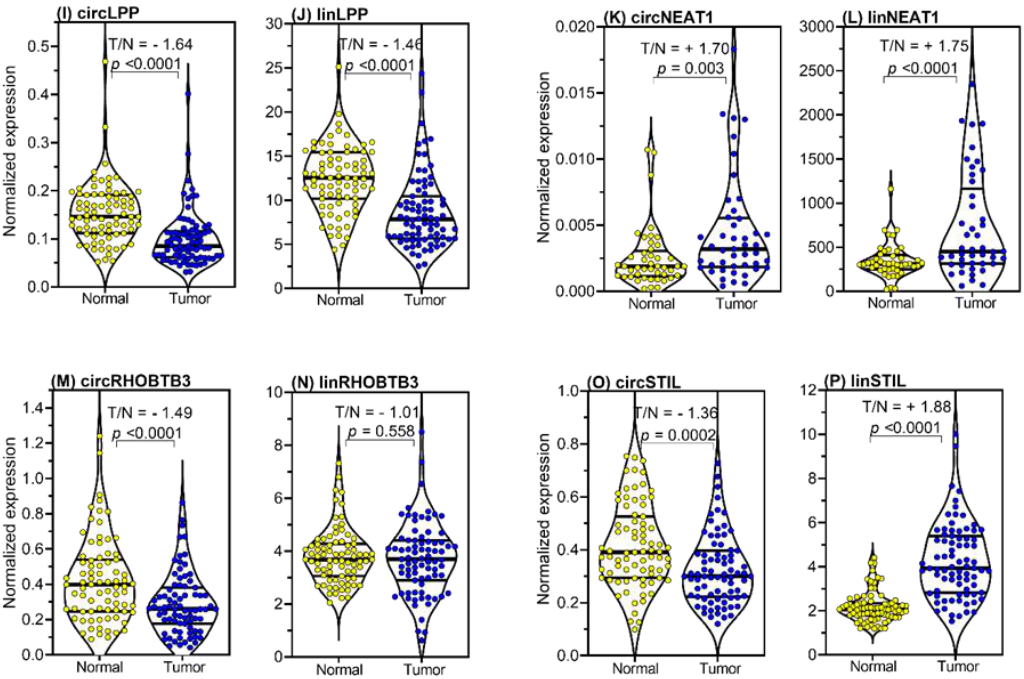
Figure 4. Expression levels of circular RNAs (circRNAs) and the linear transcripts of their host genes in tissue samples from prostate cancer (PCa) patients. The expression data of all eight circRNAs ( A , C , E , G , I , K , M , O ) and their corresponding linear transcripts ( B , D , F , H , J , L , N , P ) are shown in the matched pairs of adjacent normal tissue samples and malignant samples from PCa specimens collected by radical prostatectomy ( n = 79, only 45 for circ NEAT1 and lin NEAT1 ). ALAS1 (5 (cid:48) -aminolevulinate synthase 1) and HPRT1 (hypoxanthine phosphoribosyltransferase 1) mRNAs were used as stable expression normalizers of prostatic cancer [81]. Complete violin plots with the entire expression ranges, the lower and upper quartiles (dashed lines), and the medians (bold lines) are presented. Statistically significant expression differences of the malignant tissue samples compared with the adjacent normal tissue samples are given as the T / N (tumor / normal) index. To facilitate a direct comparison of the expression results of each circRNA and its corresponding linear transcript in the tumor to normal tissue, we used the term T / N index. A positive number indicates a higher expression in tumor tissue (numerator in the index)